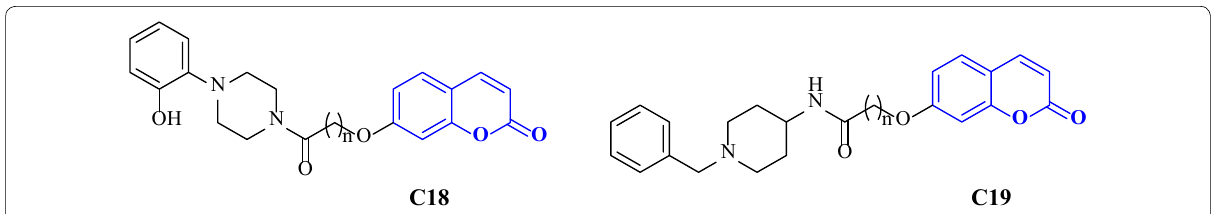
Fig. 26 Benzylpiperidinylamino derivative C18 and (2-fluorophenyl)piperazine derivative